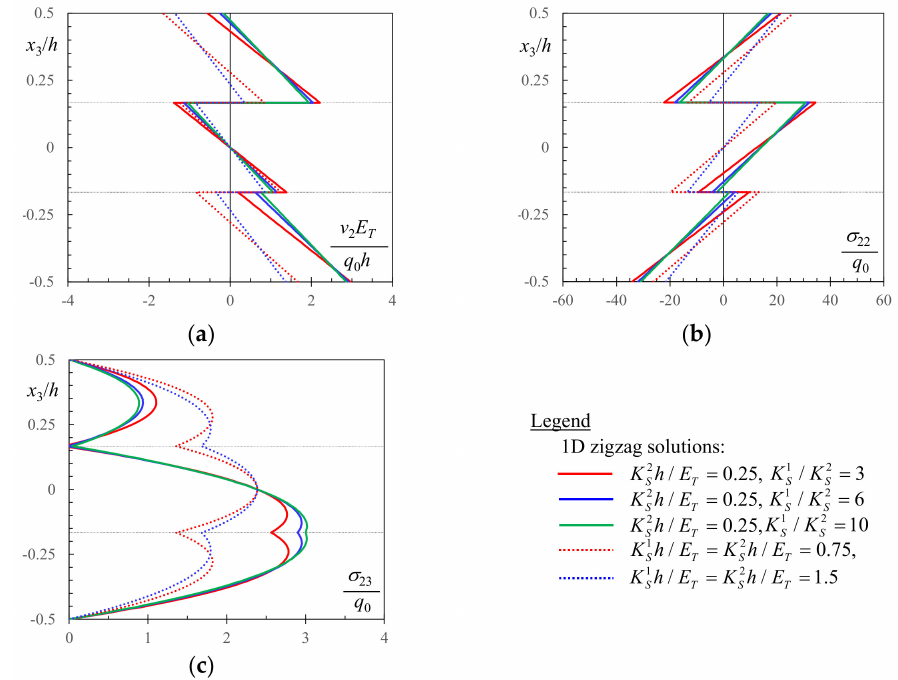
Figure 8. 1D zigzag solutions for simply supported three-layer beam (0 ◦ /0 ◦ /0 ◦ ) with L / h = 5 h / E T = 0.25 ) and subjected to sinusoidal transverse load: having interfaces of different stiffness ( K 2 S ( a ) local longitudinal displacements (at x 2 = 0); ( b ) bending stresses (at x 2 = 0.5 L ); ( c ) transverse shear stresses (at x 2 = 0) determined from local equilibrium. The dotted lines correspond to the h / E T = K 2 h / E T = 0.75 (red dotted lines) and solutions for both interfaces having equal stiffness K 1 S S 1.5 (blue dotted